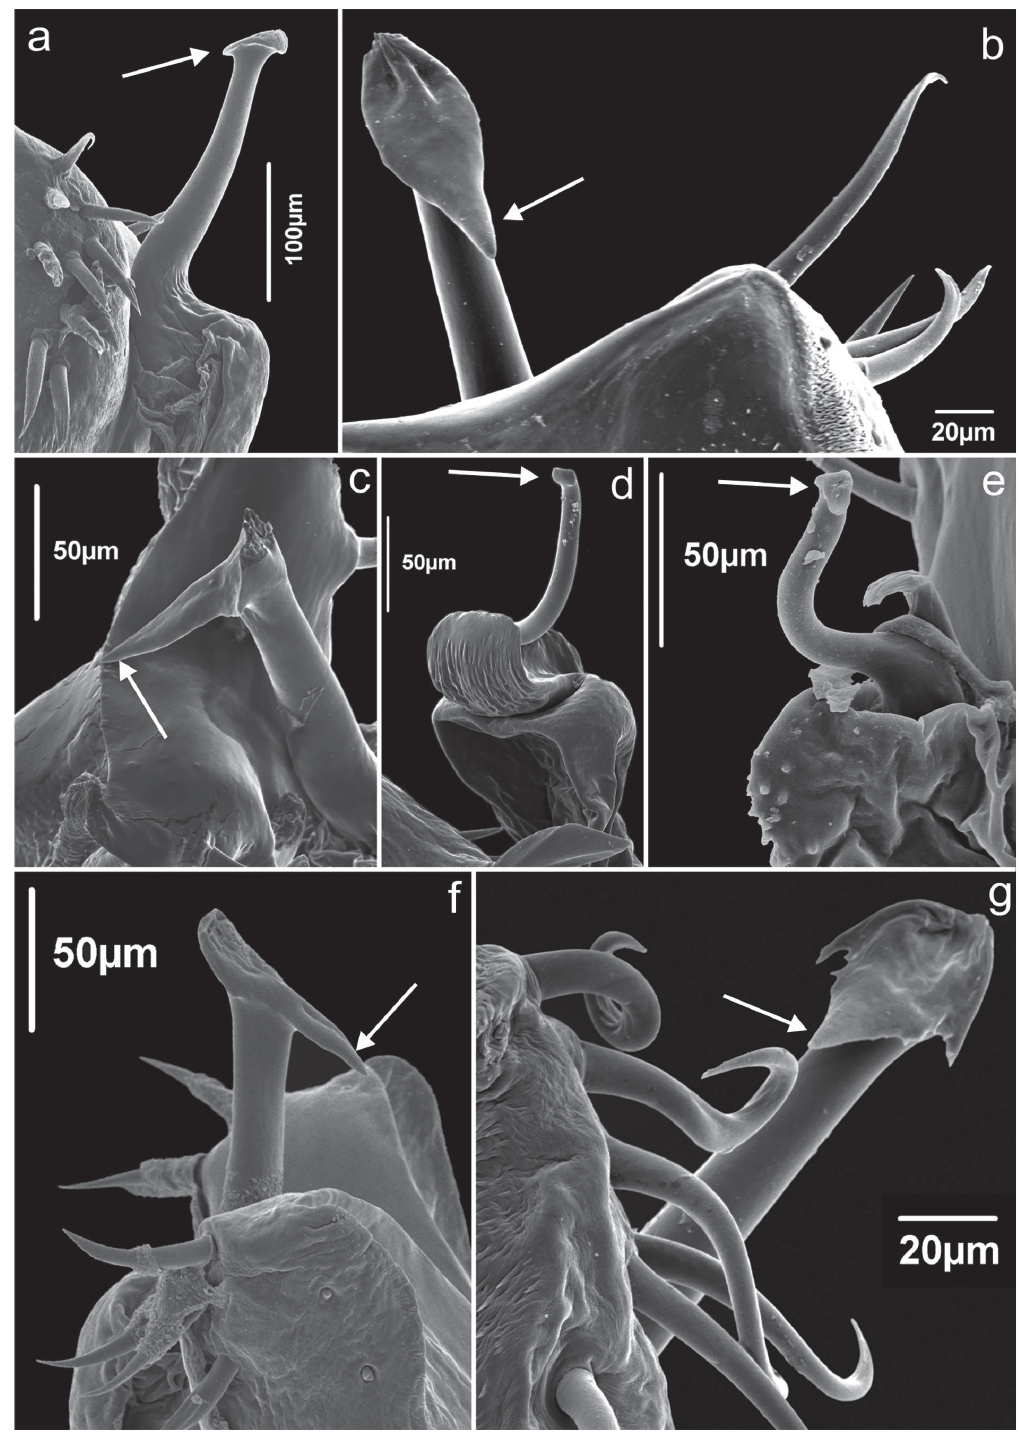
Fig. 16. Stylar caps in some cranaids species. — a-e . Cranainae. a . Phalangodus anacosmetus Gervais, 1842 (ICN-AO 1000). b . Phareicranaus giganteus Mello-Leitão, 1940 (MNRJ 19263). c . Ventrifurca caffeinica Villarreal, Kury & Pinto-da-Rocha, 2015 (MNRJ 7038). d . Phareicranaus albilineatus author+year (MNRJ 7916). e . Phareicranaus duranti (González-Sponga, 1989) (MNRJ 7818). — f . Heterocranainae. Heterocranaus sp. (MNRJ 7634). — g . Stygnicranainae. Agathocranaus sp. (MNRJ 8437). a, c, f. Lateral view. b, g. Ventral view. d–e. Oblique view. Arrows indicate stylar